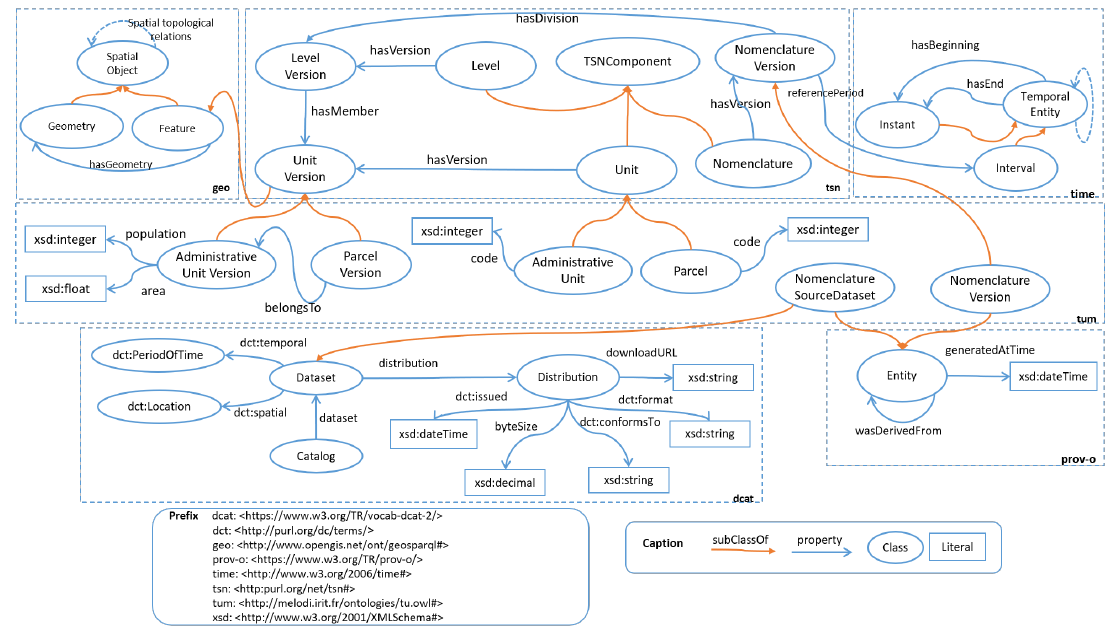
Figure 1. The Territorial Unit Model ontology to represent territorial units (such as French administrative units and land registry parcels), and their